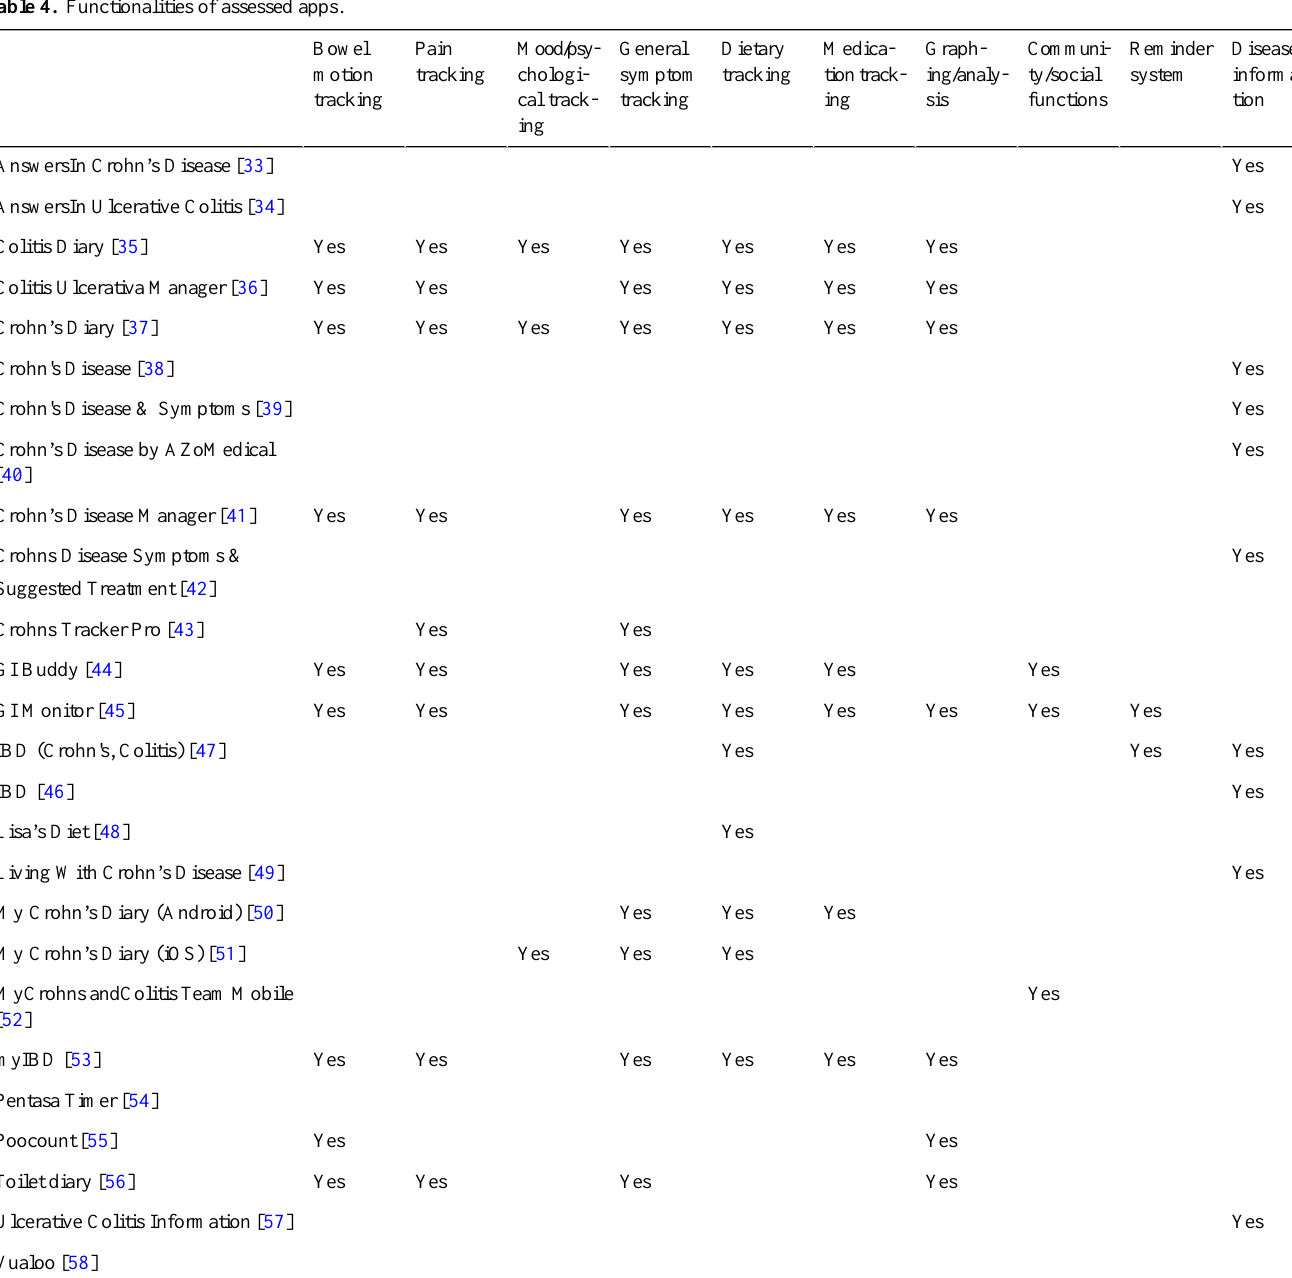
Table 4. Functionalities of assessed apps.